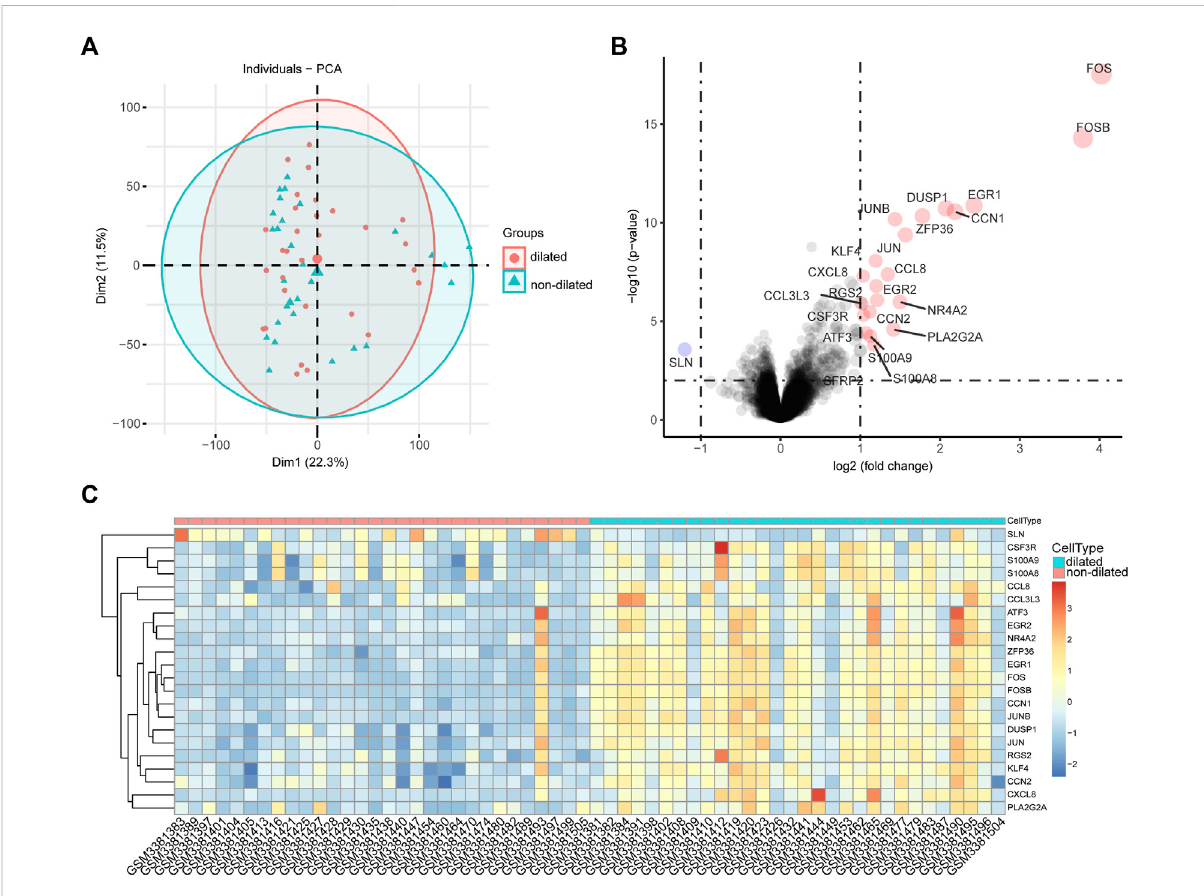
FIGURE 1 Intra-group repeatability for GSE119717 dataset. (A) All samples from the GSE119717 dataset were analyzed by principal component analysis. Principal component 1 is on the X -axis; principal component 2 is on the Y -axis. (B) Volcano plot showing DEGs between the two groups. X -axis represents the |log fold change|; Y -axis represents the p -value (log-scaled). The red dots represent the up-regulated DEGs and the blue dot represents the down-regulated DEGs. (C) Heatmap visualizing DEGs between the two